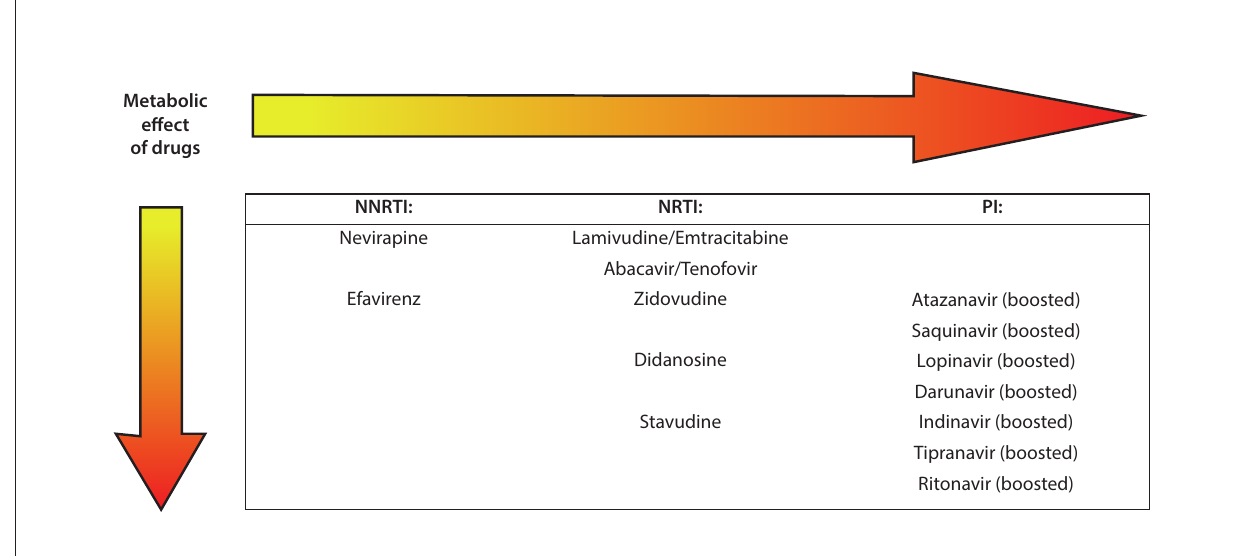
Fig. 1. Metabolic impact of ART classes and individual drugs. [8] NNTRI = non-nucleoside reverse transcriptase inhibitor; NRTI = nucleoside reverse transcriptase inhibitor; PI = protease inhibitor.